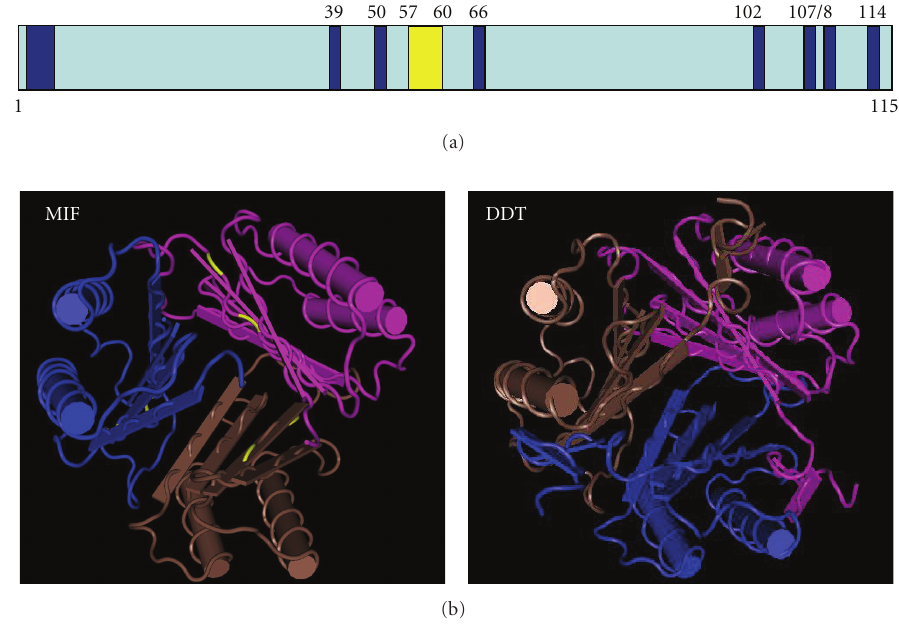
Figure 2: Structural homologies of MIF and DDT. (a) Primary structural scheme of the human MIF gene. Yellow region indicates the CXXC domain, the blue boxed domains indicate the proposed tautomerase/isomerase domains and clustered amino acids (Phe3, Val39, Gly50, Lys66, Asn102, Gly107, Trp108, Phe113, and Ala114) [18]. (b) Structural comparison of human MIF and DDT trimers. The catalytically important CXXC domain is shown in yellow. β -sheets are given as arrows, and α -sheets are shown as columns. Data were obtained from the NCBI database (http://www.ncbi.nlm.nih.gov/Structure/mmdb/mmdbsrv.cgi?uid = 89970) based on the study of